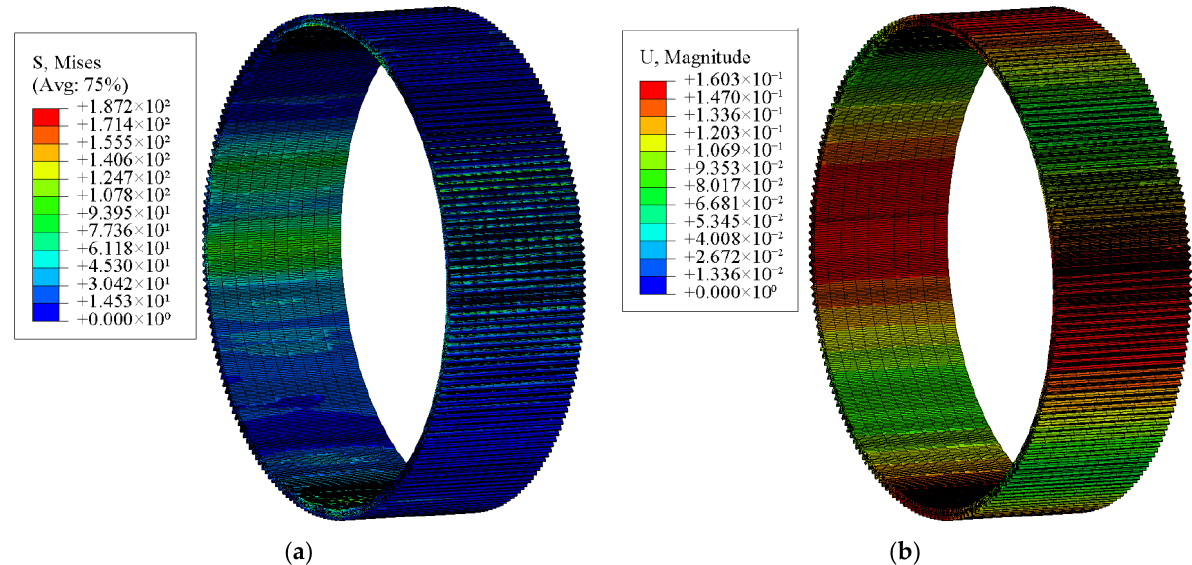
Figure 19. ( a ) Equivalent stress of the flexible wheel after assembly; ( b ) equivalent deformation of the flexible wheel after assembly.